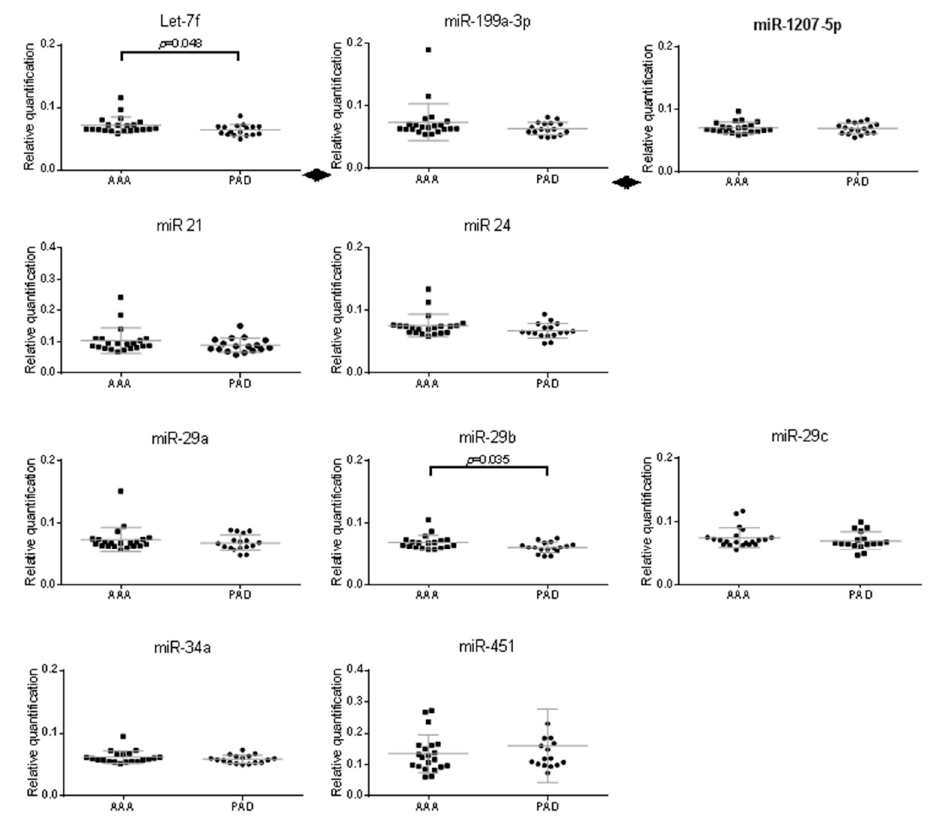
Figure 4. Quantification of the ten miRNAs in plasma from patients with AAA ( n = 22) and in patients with PAD without AAA ( n = 17) by RT-qPCR with the Δ Ct method with Syn-cel-miR-39 for calibration. Data are expressed as the mean Δ Ct ± SEM and show the individual values obtained for each miRNA quantified. The exact p- value is indicated for the significant differential expression between PAD and AAA patients.